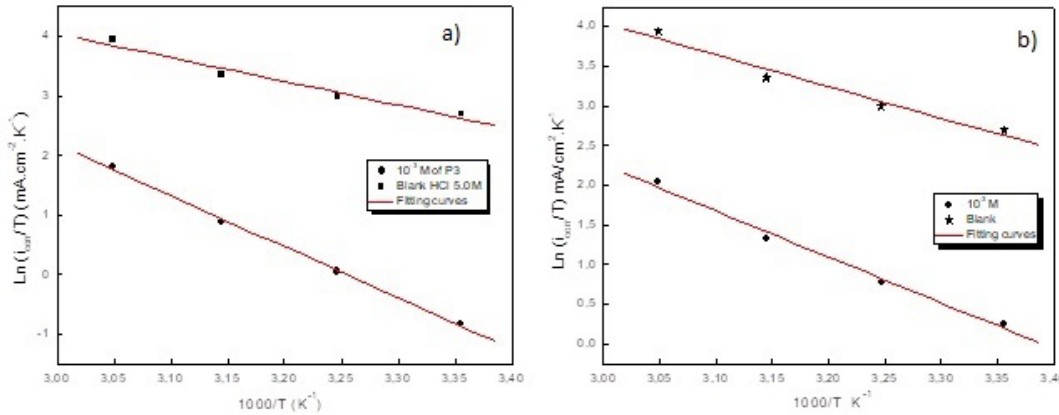
Figure 8. Transition Arrhenius plots of ordinary mild steel in 5.0 M HCl without and with 10-3 M of (a) P3 or (b)